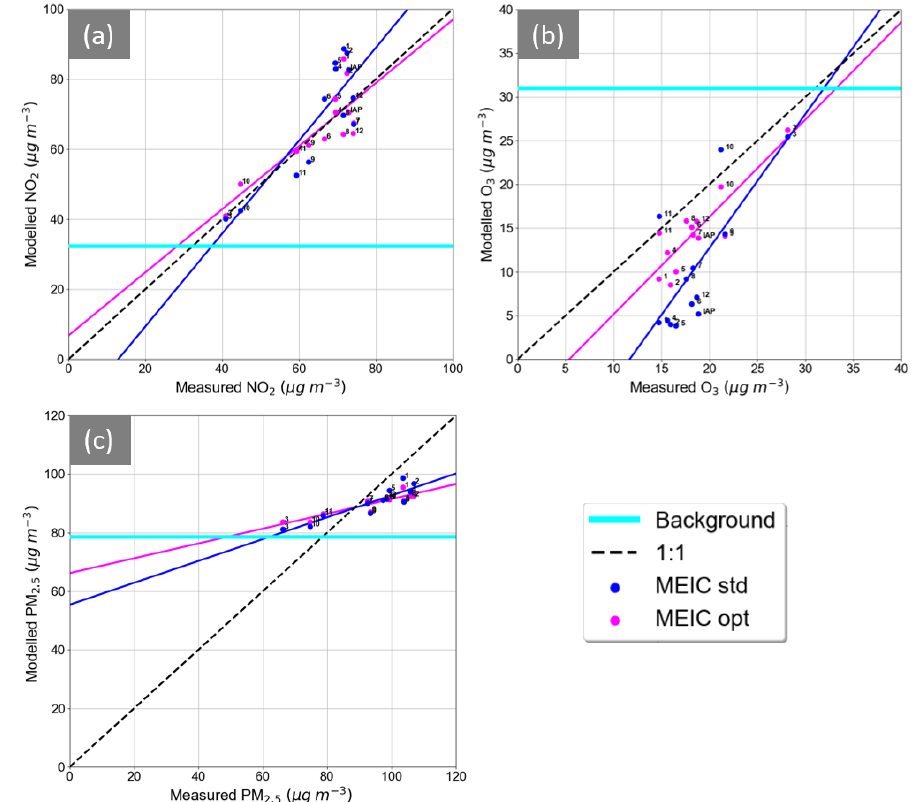
Figure 7. Campaign period mean measured and modelled (a) NO 2 , (b) O 3 , and (c) PM 2 . 5 concentrations at all monitoring network sites (numbered) and the IAP field site (NO 2 and O 3 ). Blue and pink lines indicate concentrations simulated using MEIC Std and MEIC Opt, respectively. Horizontal light blue line represents campaign period mean background concentrations calculated from measurements.